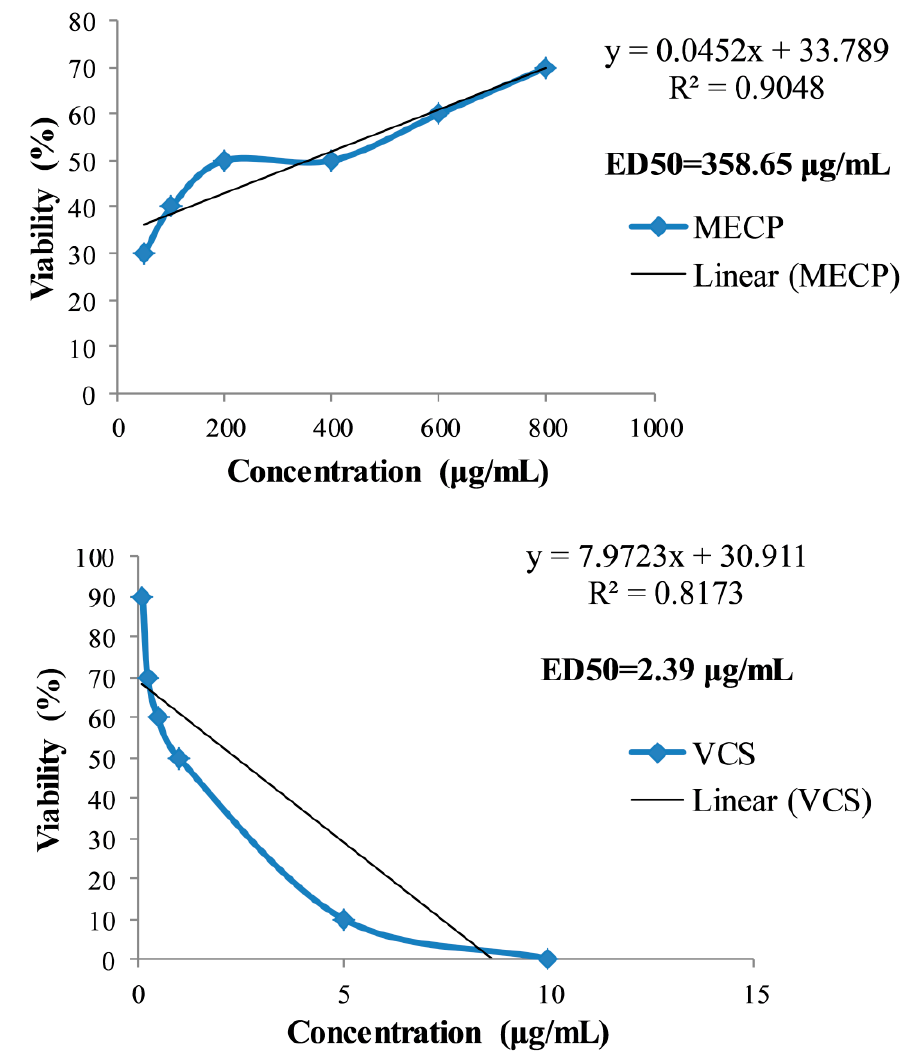
Figure 2. Percentage of mortality of brine shrimp lethality bioassay of methanol extract of C. pectinata leaves (MECP) and standard drug vincristine sulfate (VCS) at different concentrations.